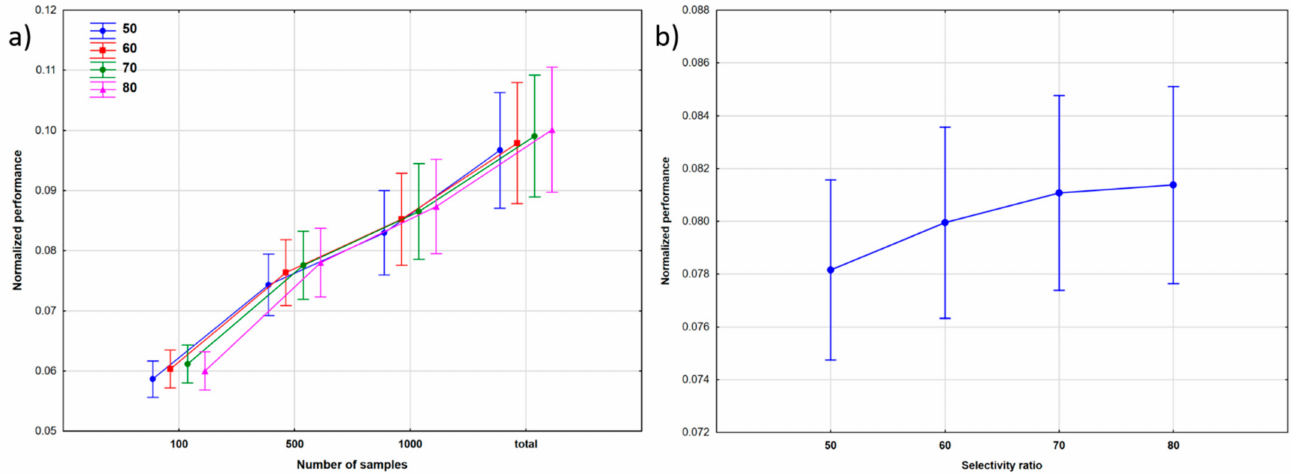
Figure 2. The effect of: ( a ) the number of samples (NS) at different split ratios, and ( b ) the split ratios (SR) on the performance of the